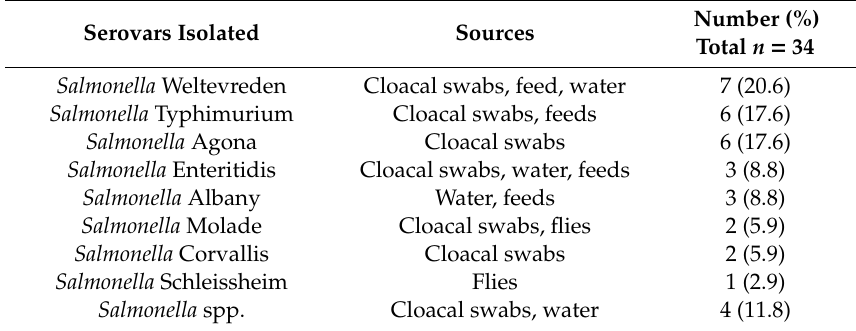
Table 5. Distribution of Salmonella serovars isolated across di ff erent samples from village chicken flocks in the South-central Peninsular